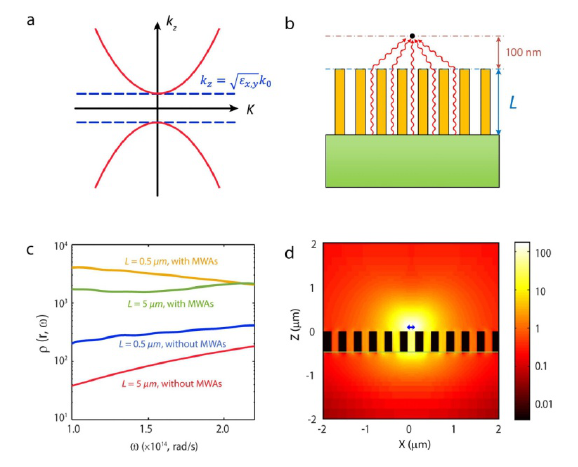
Figure 7: Hyperbolic metamaterials (HMs) mediated near-field ther- mal extraction. (a) Dispersion relation of typical HMs (red curves) and metal wire arrays (MWAs) (blue dashed lines). (b) Schematic of the MWA-based near-field thermal extractor. (c) Calculated photon local density of states (PLDOS) at 100 nm above MWAs for different lengths L = 500 nm and L = 5 µm with/without the MWAs. (d) Electric field intensity excited by a dipole located at 100 nm above the 500 nm thick slab of MWAs